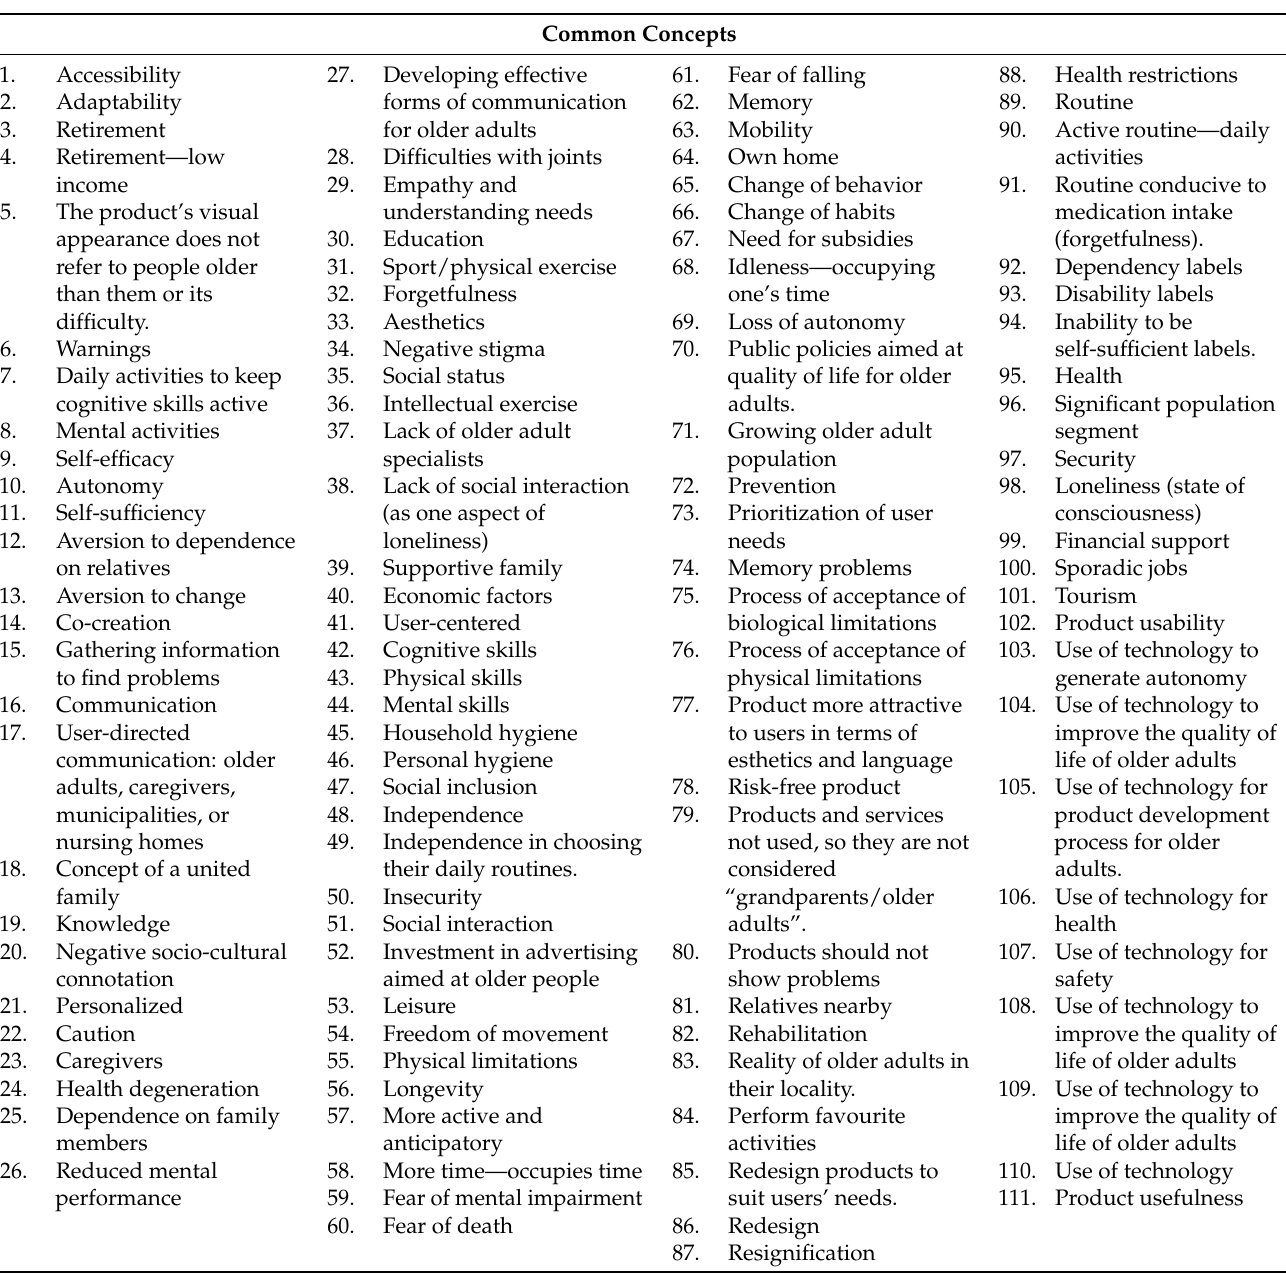
Table 2. “Common concepts” category between the categories “Needs of older adults” and “Solutions for older